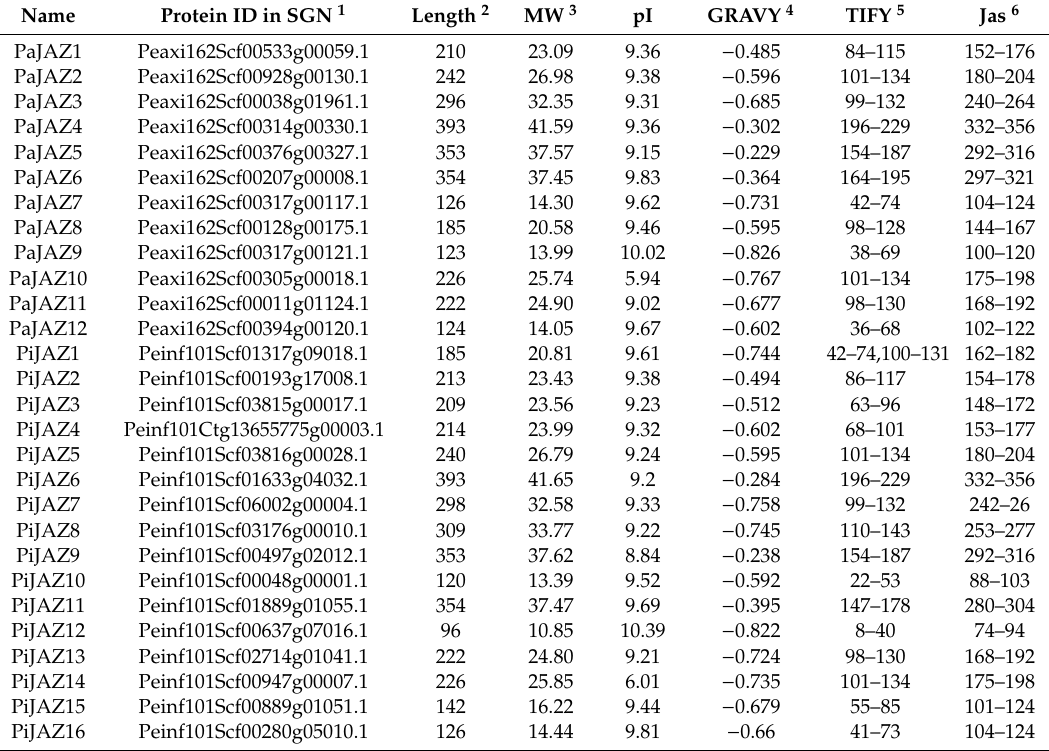
Table 1. The sequence properties of the 28 JAZ family proteins identified in P. axillaris and P. inflata